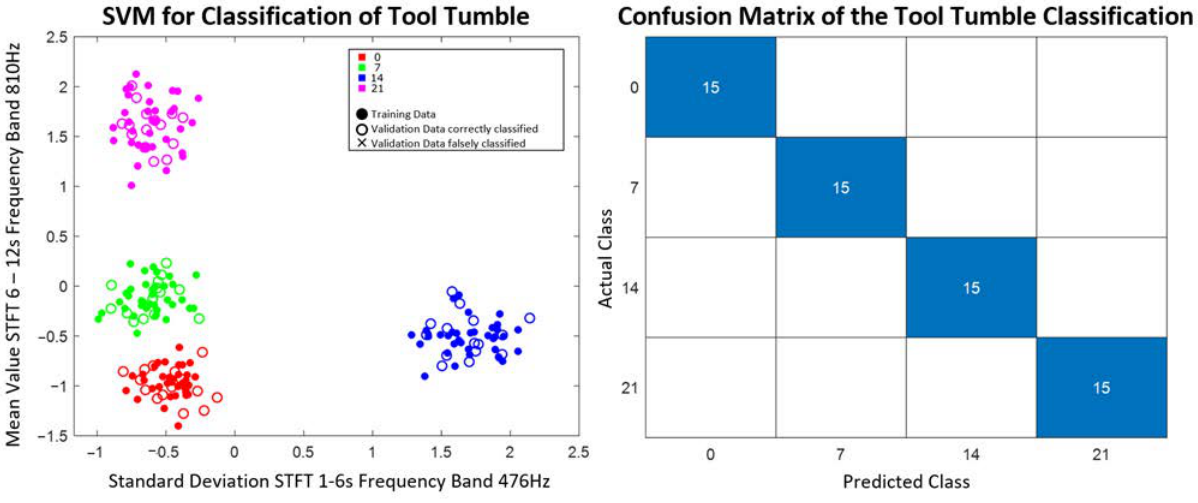
Figure 12. Best two features and confusion matrix for tool tumble classification (feature selection: ANOVA+rs from raw signal and